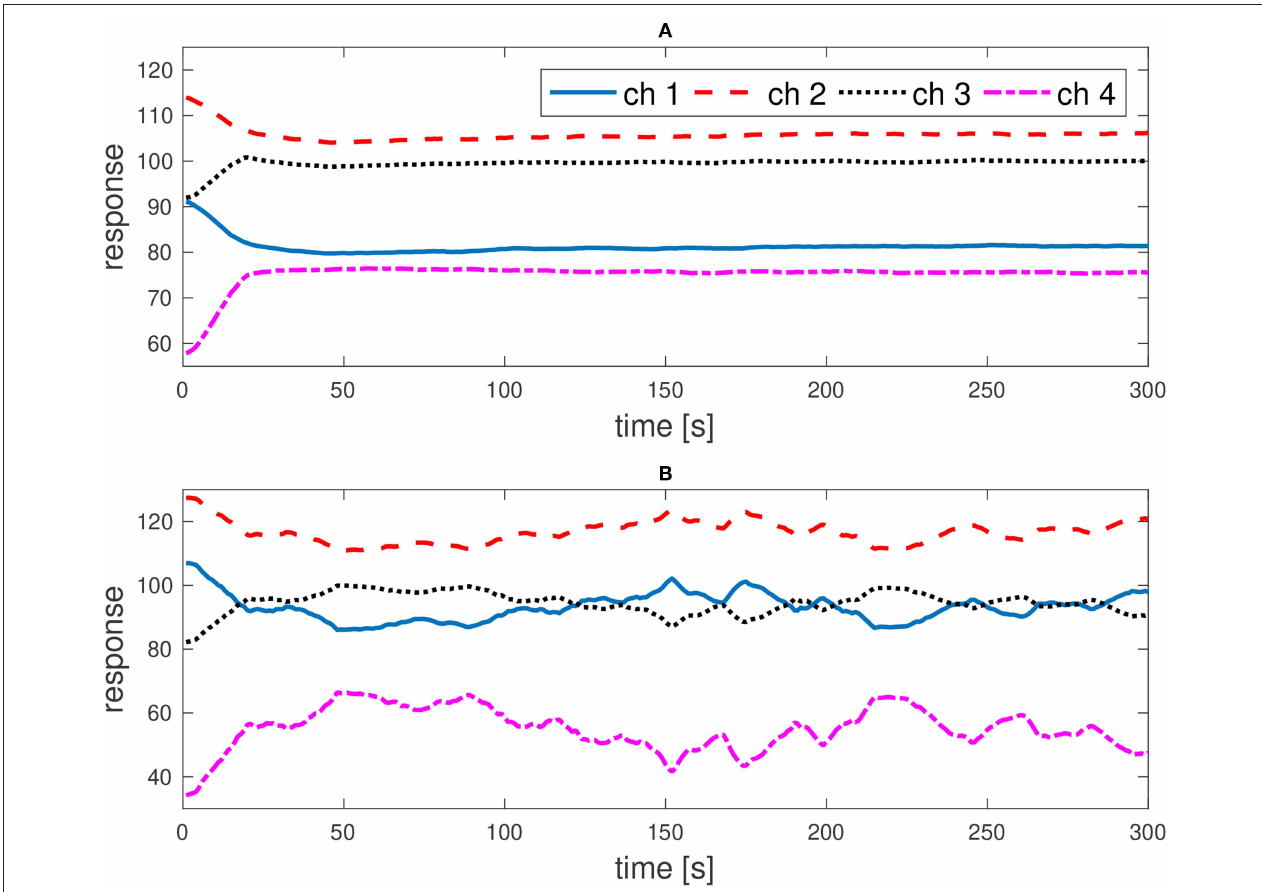
FIGURE 1 | Temporal responses on IMS channels 1 to 4 for grated lemon peel. Scent source was presented to ChemPro100i in (A) a sealed flask and (B) on a plate. Measurement frequency was